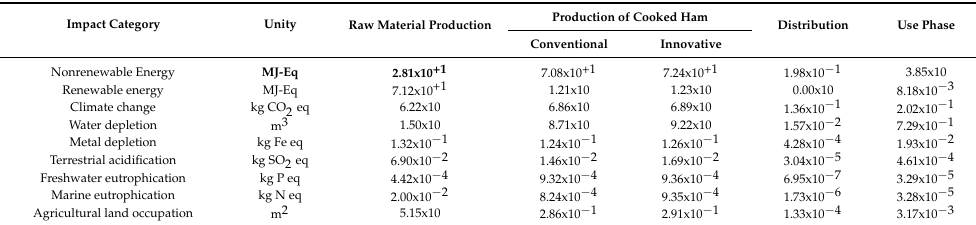
Table 4. Hotspots analysis of cooked ham life cycle impacts for conventional and innovative pro-